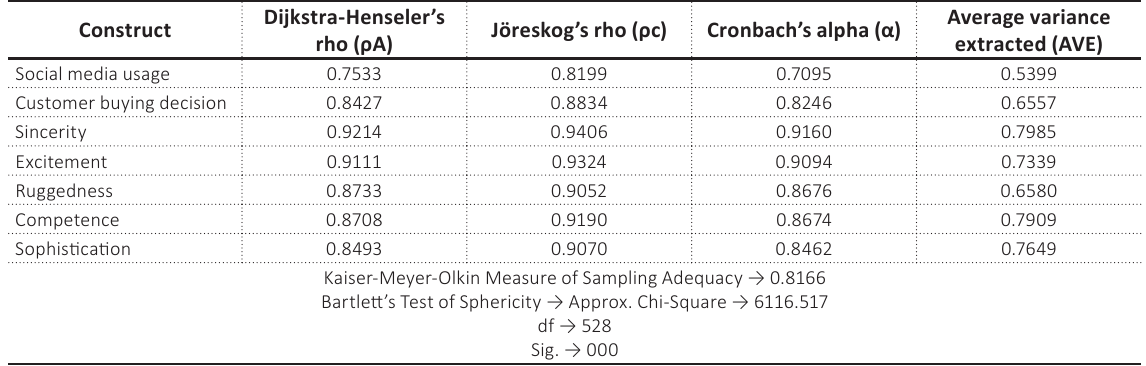
Source: Authors’ processing from ADANCO 2.2.1 and SPSS software.